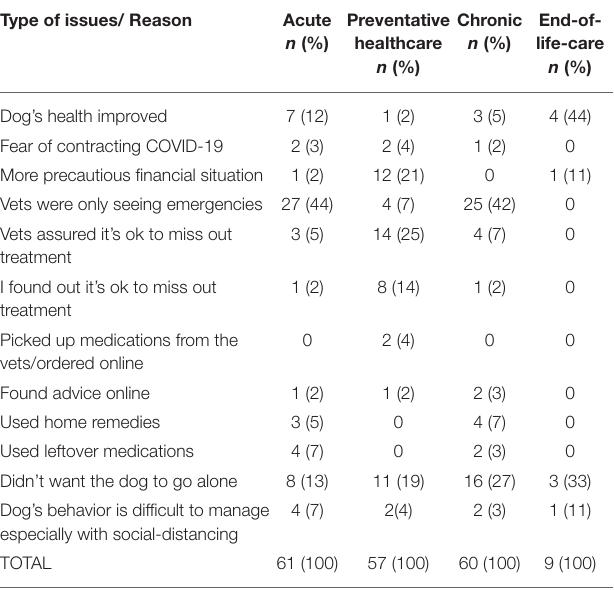
TABLE 6 | Reasons for not seeking/ being unable to access care for different health issues; n